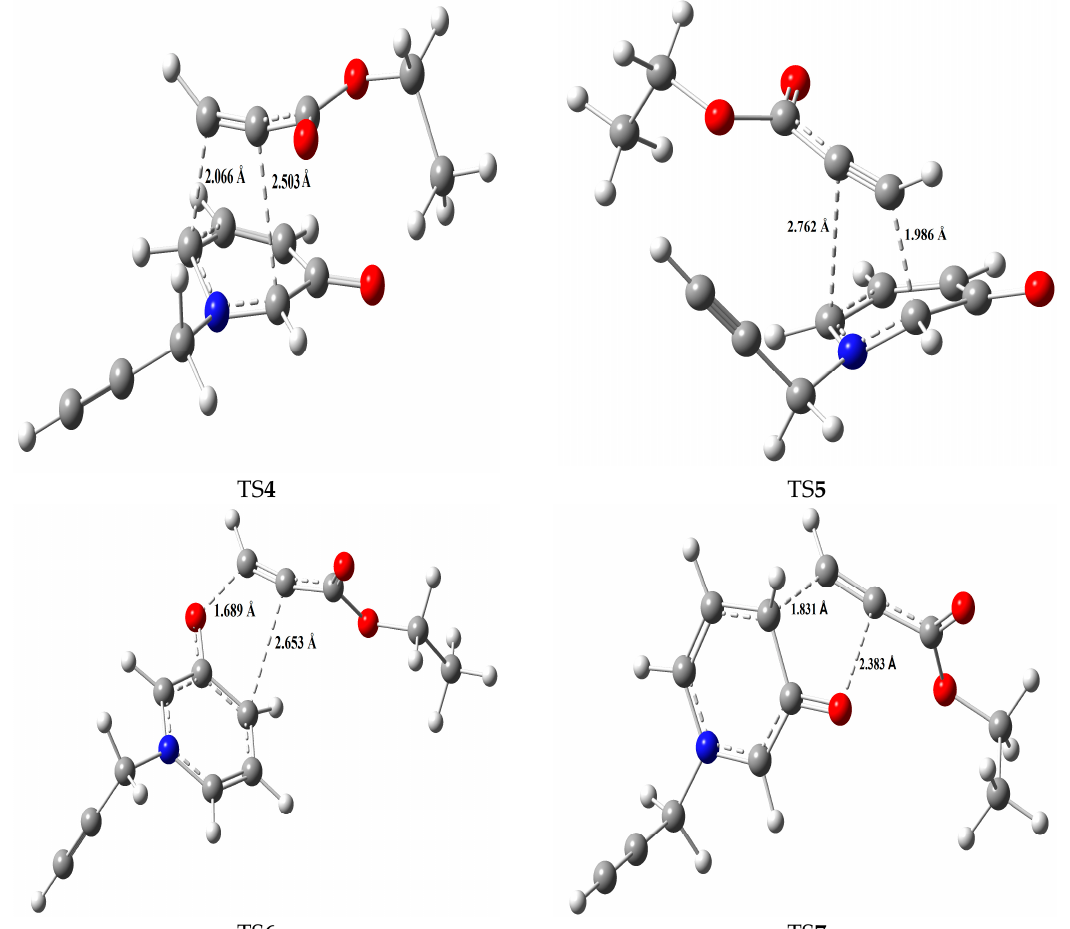
Figure 2. The four transition state structures of the studied CA reaction. Table 3. Energies and relative energies ( ∆ E) of the reactants, transition states, and